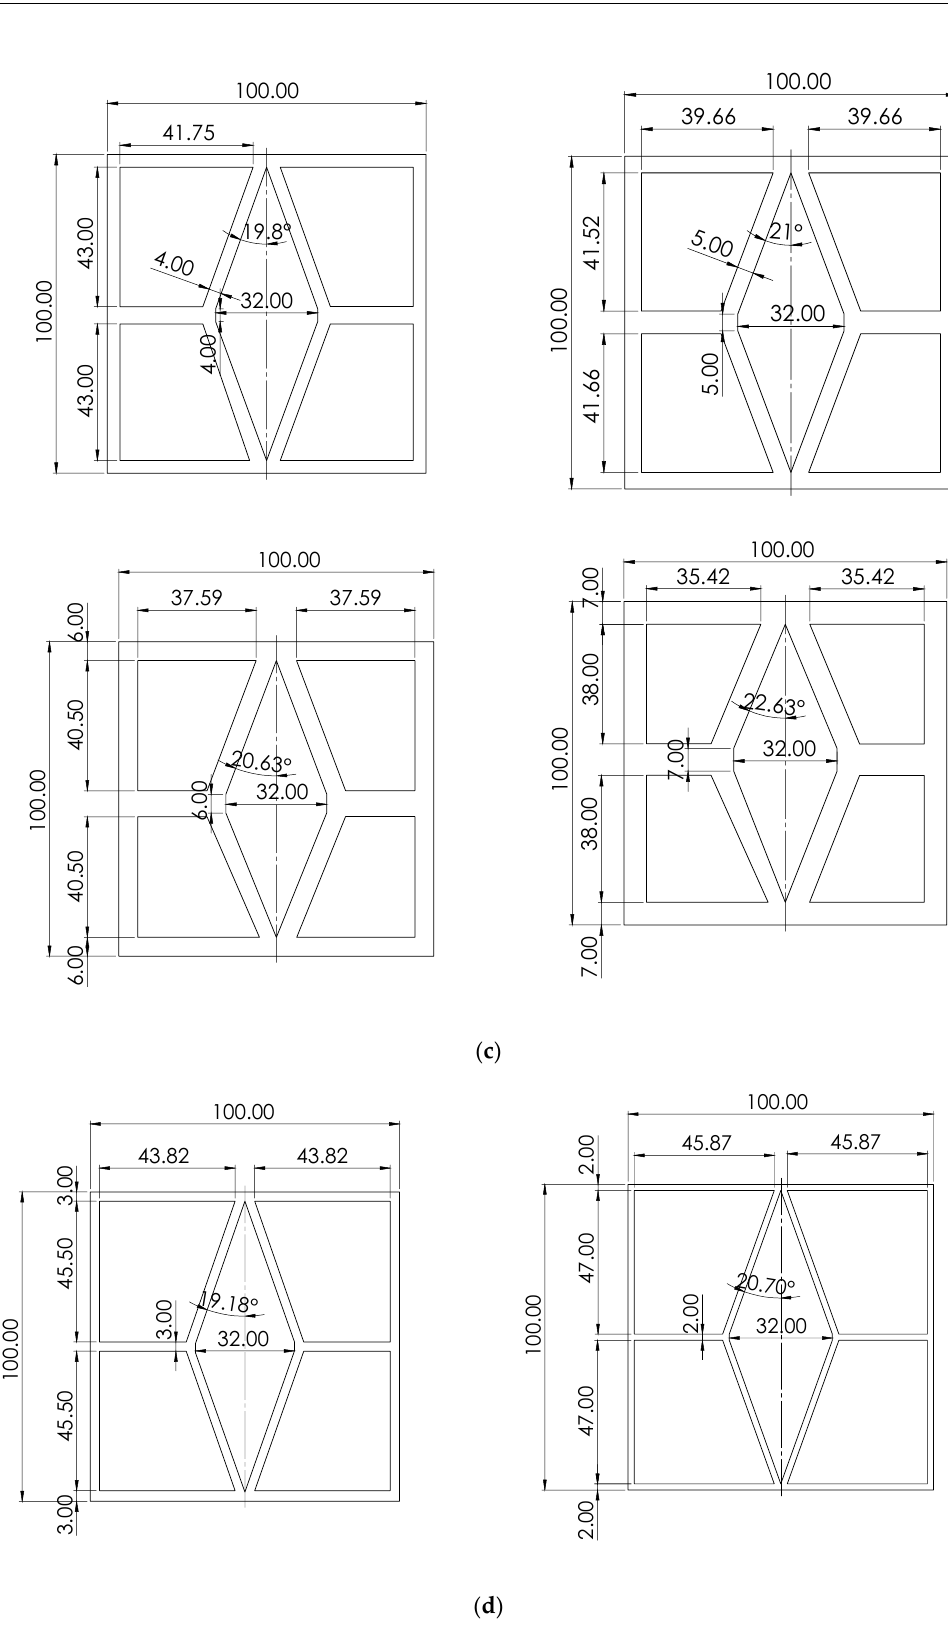
Figure 4. Cross-sectional geometries: ( a ) non-slender Q1–Q4; ( b ) non-slender K1–K4, (geometries based [5]); ( c ) non-slender S1–S4 (developed [1]); ( d ) slender S5–S6 (developed [1]). All cross-sections were 100 mm × 100